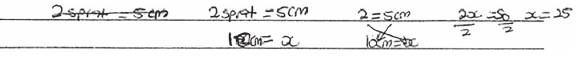
FIGURE 5: Response of Learner 6 to Question 2a(i).